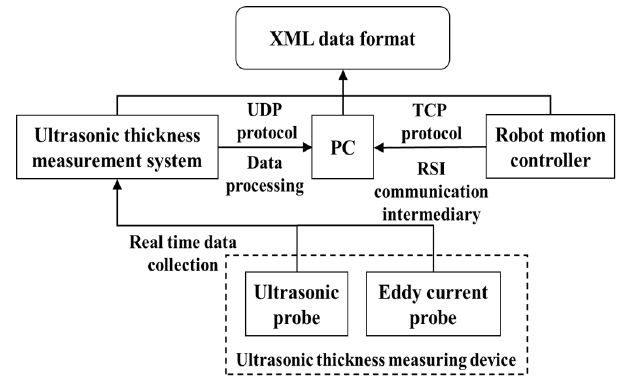
Figure 3. System communication